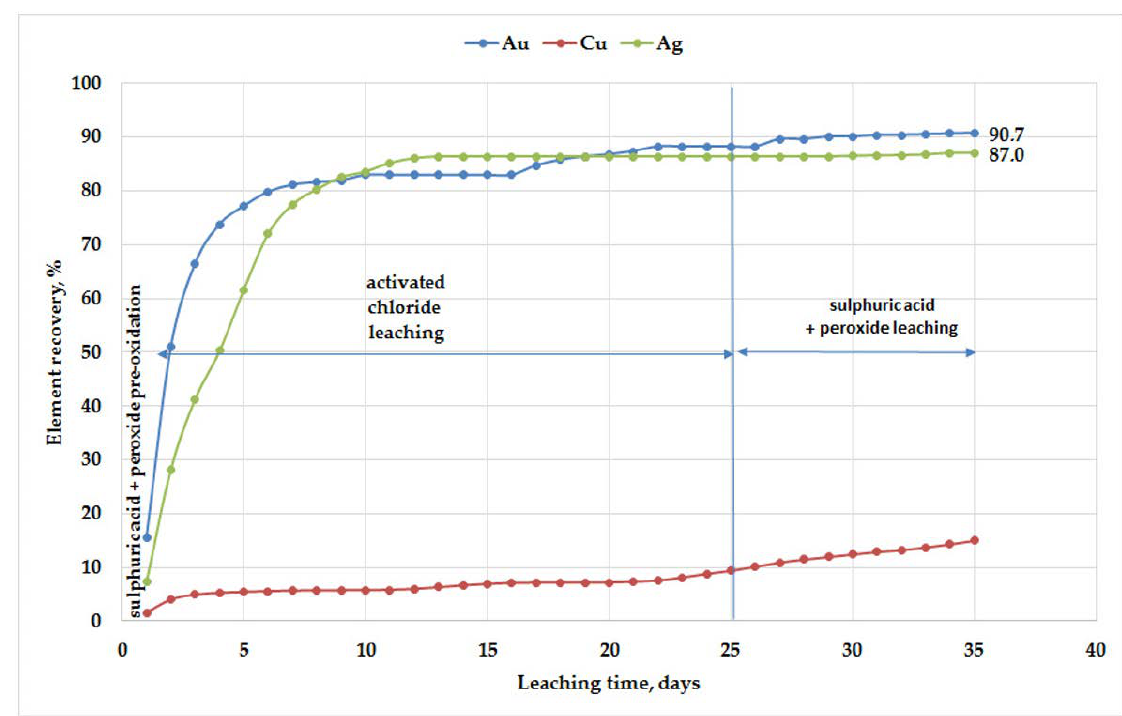
Figure 3. Gold, copper and silver extractions of oxidized ore during column